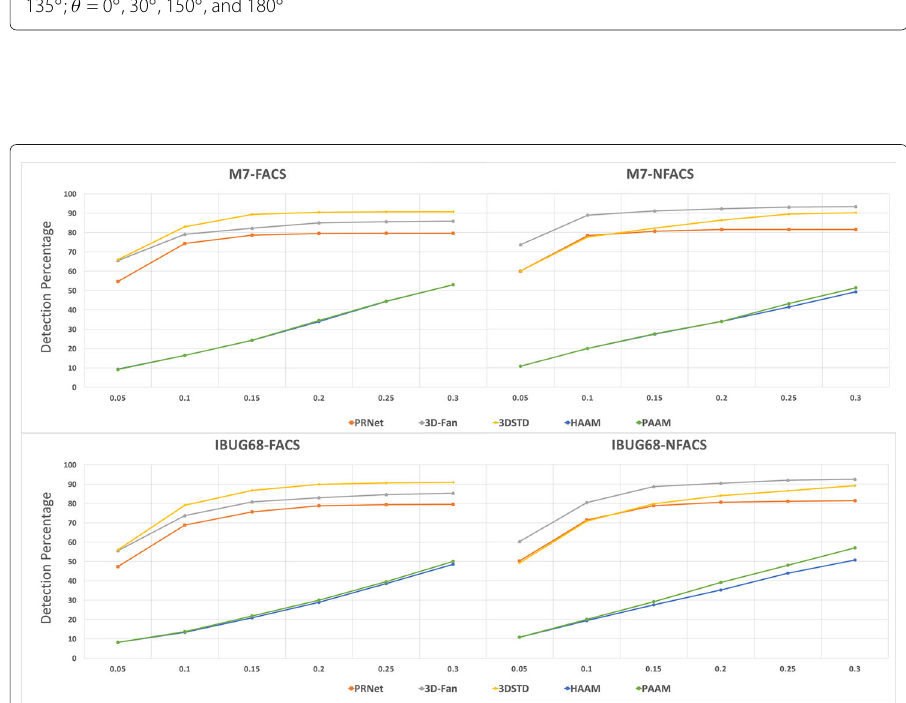
Fig. 18 FACS and non-FACS comparison. a FACS NRMSE and non-FACS NRMSE with M7 and b is iBUG-68 landmark